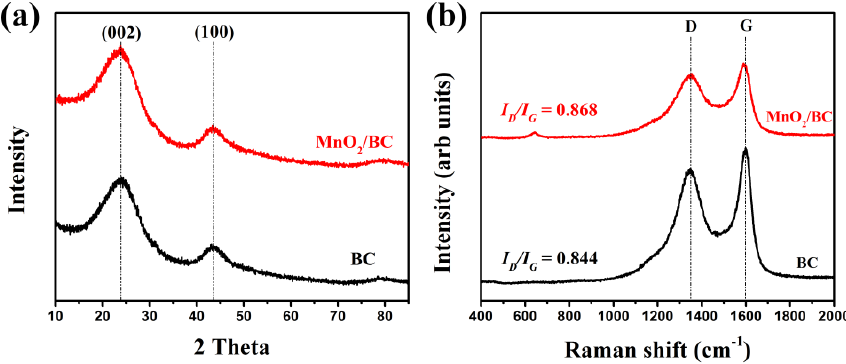
Figure 2. ( a ) XRD pattern and ( b ) Raman spectrum of the BC and MnO 2 /BC hybrids.